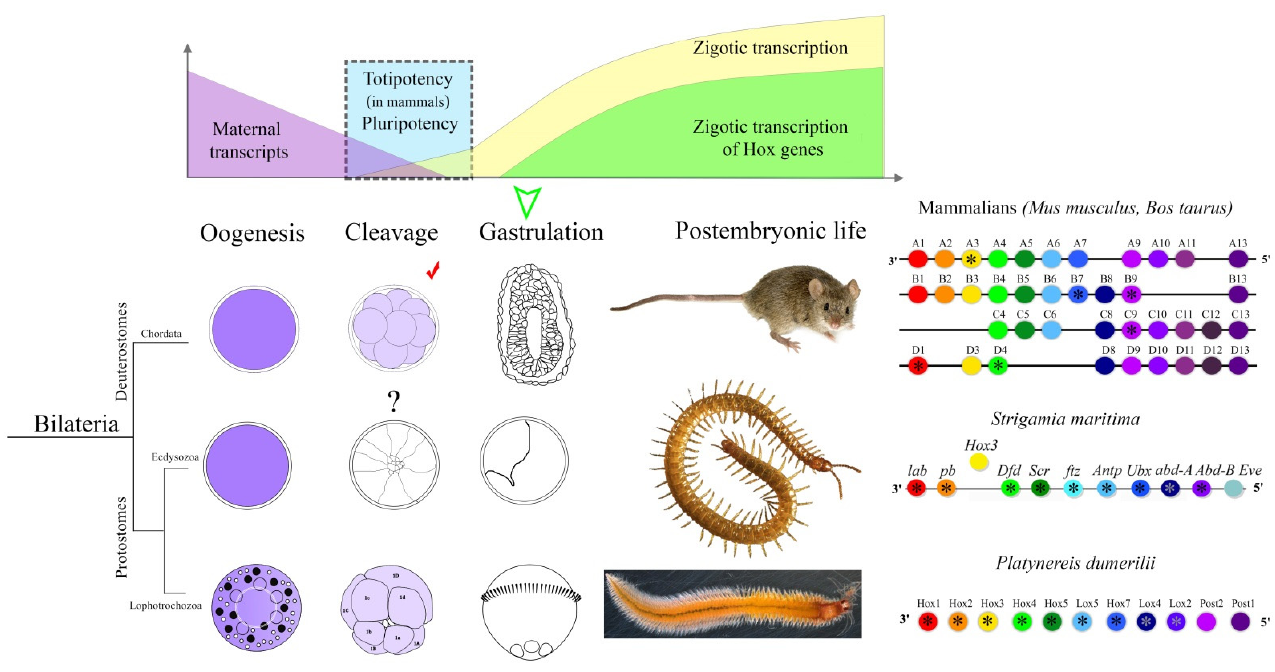
Figure 2. The dynamics of development of bilateral animals in the coordinates of the work of the maternal and zygotic genomes. The upper part of the illustration shows a graph of the activation of the zygotic genome, which is common to many bilaterian [23,24]. Zygotic transcripts of Hox genes (marked in green) are detected after the cleavage stage, at the moment of the onset of gastrulation. Up to this point, there is an epigenetic prohibition on their work, since they violate the state of totipotency and pluripotency. Maternal transcripts of Hox genes (marked in lilac) are present in oocytes animals from all three evolutionary lineages of Bilateria. These RNAs are degraded, but in some cases are found during cleavage (mammals and Platynereis ) and are even present as proteins (red check mark; HoxB9 in mammals). Hox clusters of animals with Hox-positive oocytes are shown on the right side of the figure. Asterisks mark Hox genes whose transcripts were found in oocytes. Solid line between genes indicates physical linkage where shown. Animal photos copied from Wikipedia.